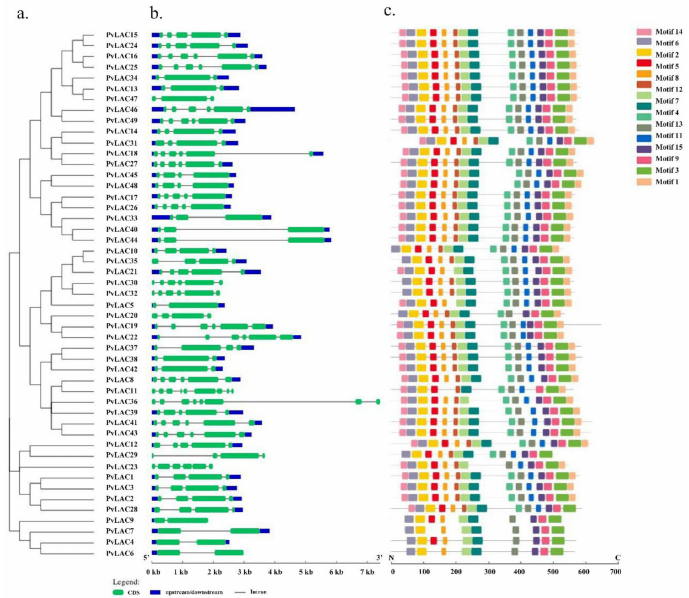
Figure 4. Structural analysis of laccases from switchgrass: ( a ) A neighbor-joining tree of 49 PvLACs constructed using MEGA 7.0; ( b ) the structure of 49 PvLAC genes. Green squares represent exons (coding sequences, CDS) and gray lines indicate introns, while the blue squares refer to the 5’ untrans- lated region (UTR) and 3’ UTR sequences; ( c ) conserved motifs of laccase genes in 49 switchgrasses. The colored square represents 15 conserved motifs, shown in supplementary table (Table